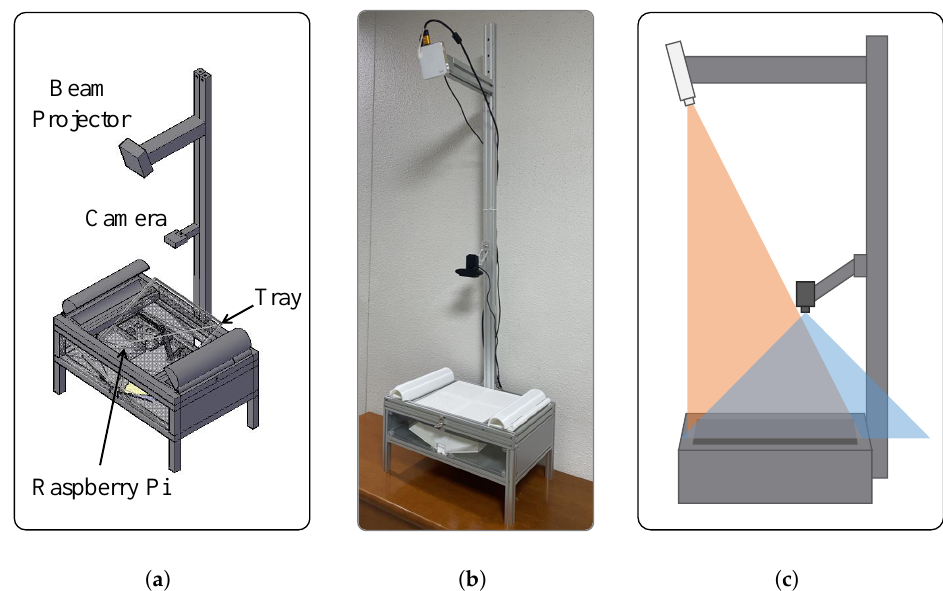
Figure 5. Local hardware device. ( a ) Cad design of the local device. ( b ) Photo of the local device. ( c ) Configuration of the camera and beam